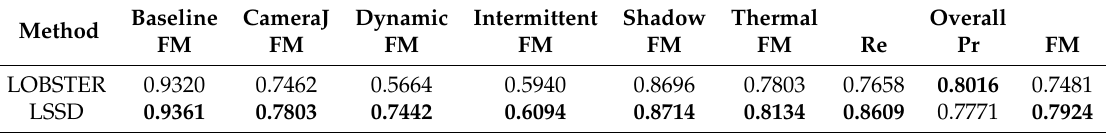
Table 5. Per-category average F-Measure comparisons between LOBSTER and LSSD with respect to the CDnet2012